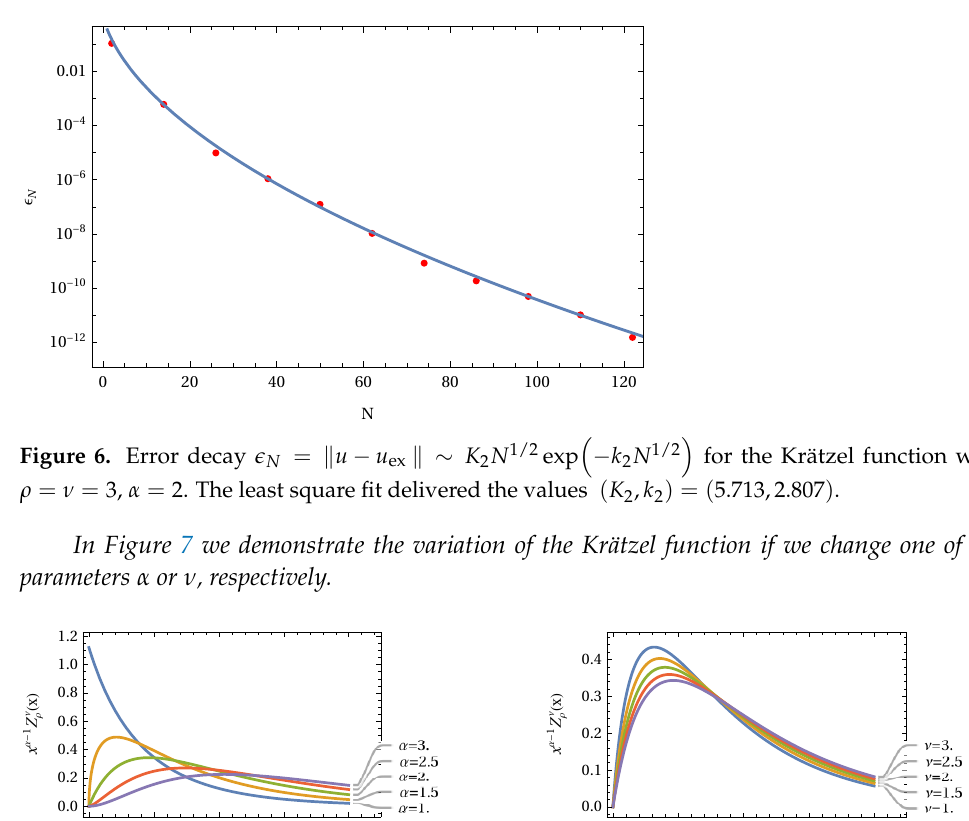
Figure 7. The Krätzel function for ρ = ν = 3 with α variation (left graph) and ν variation (right graph).